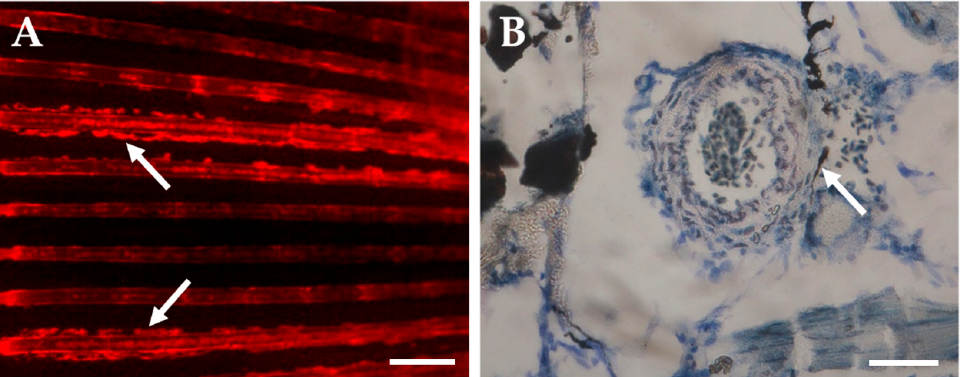
Figure 1. Vascular calcification in six-month-old zebrafish exposed for fifteen days to 25 mg/L of sodium warfarin. ( A ) Alizarin red S in vivo staining of calcified caudal fin blood vessels (white arrows) and ( B ) von Kossa’s staining of a calcified artery counterstained with toluidine blue (white arrow). Bar is 500 µm in ( A ) and is 50 µm in ( B ).